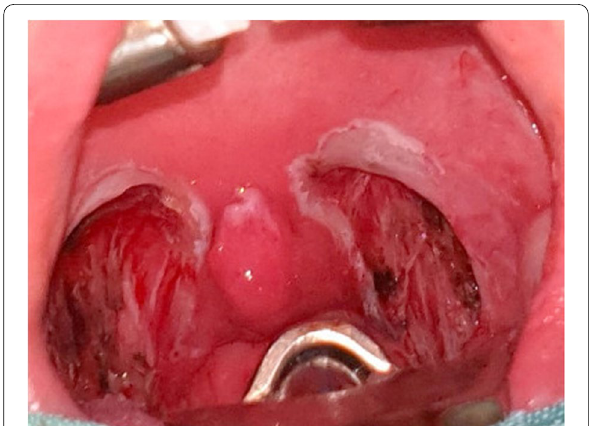
Fig. 2 Immediate postoperative image of the surgical bed in bipolar